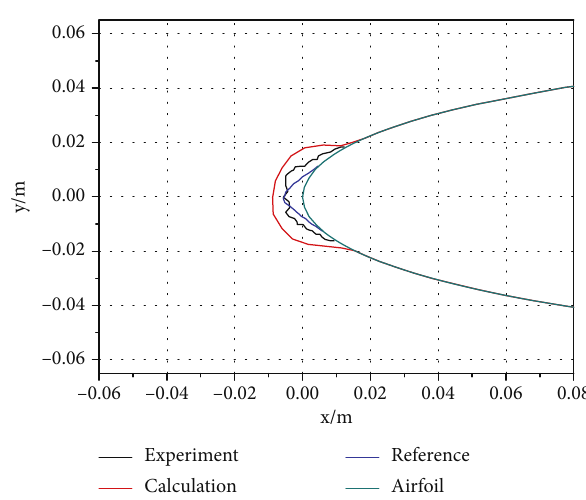
Figure 5: Comparison of ice shapes for condition